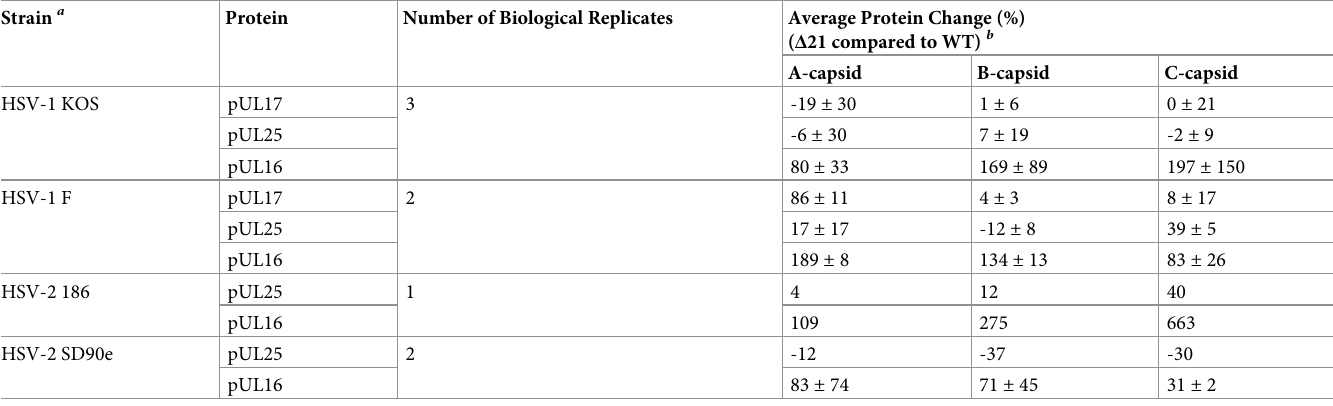
Table 1. Qualitative analysis of capsid associated proteins.